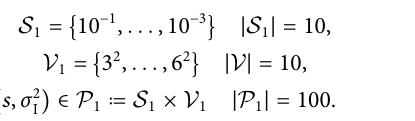
Frontiers in Robotics and AI |